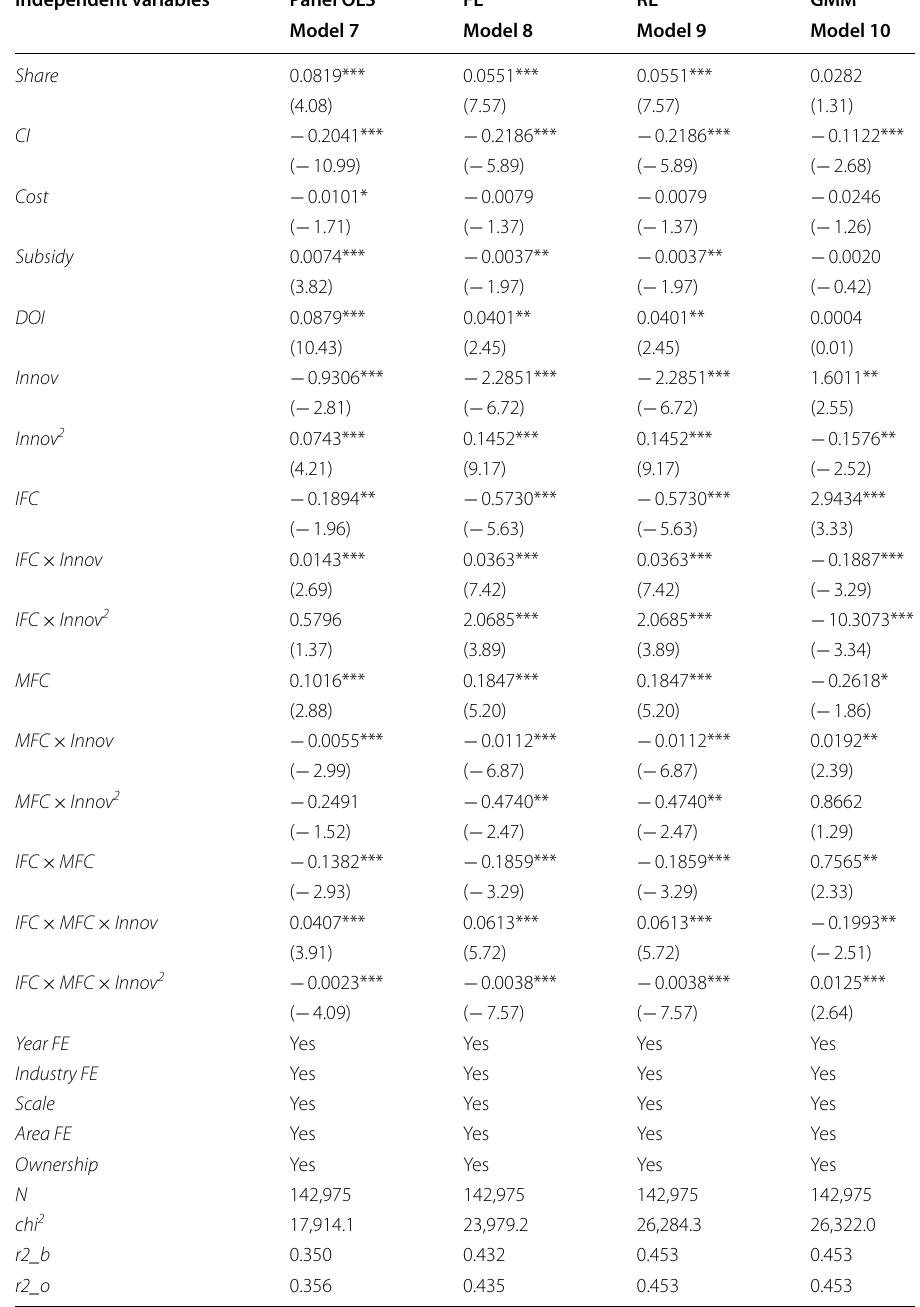
Table 5 Regression analysis results using data from 2003 to